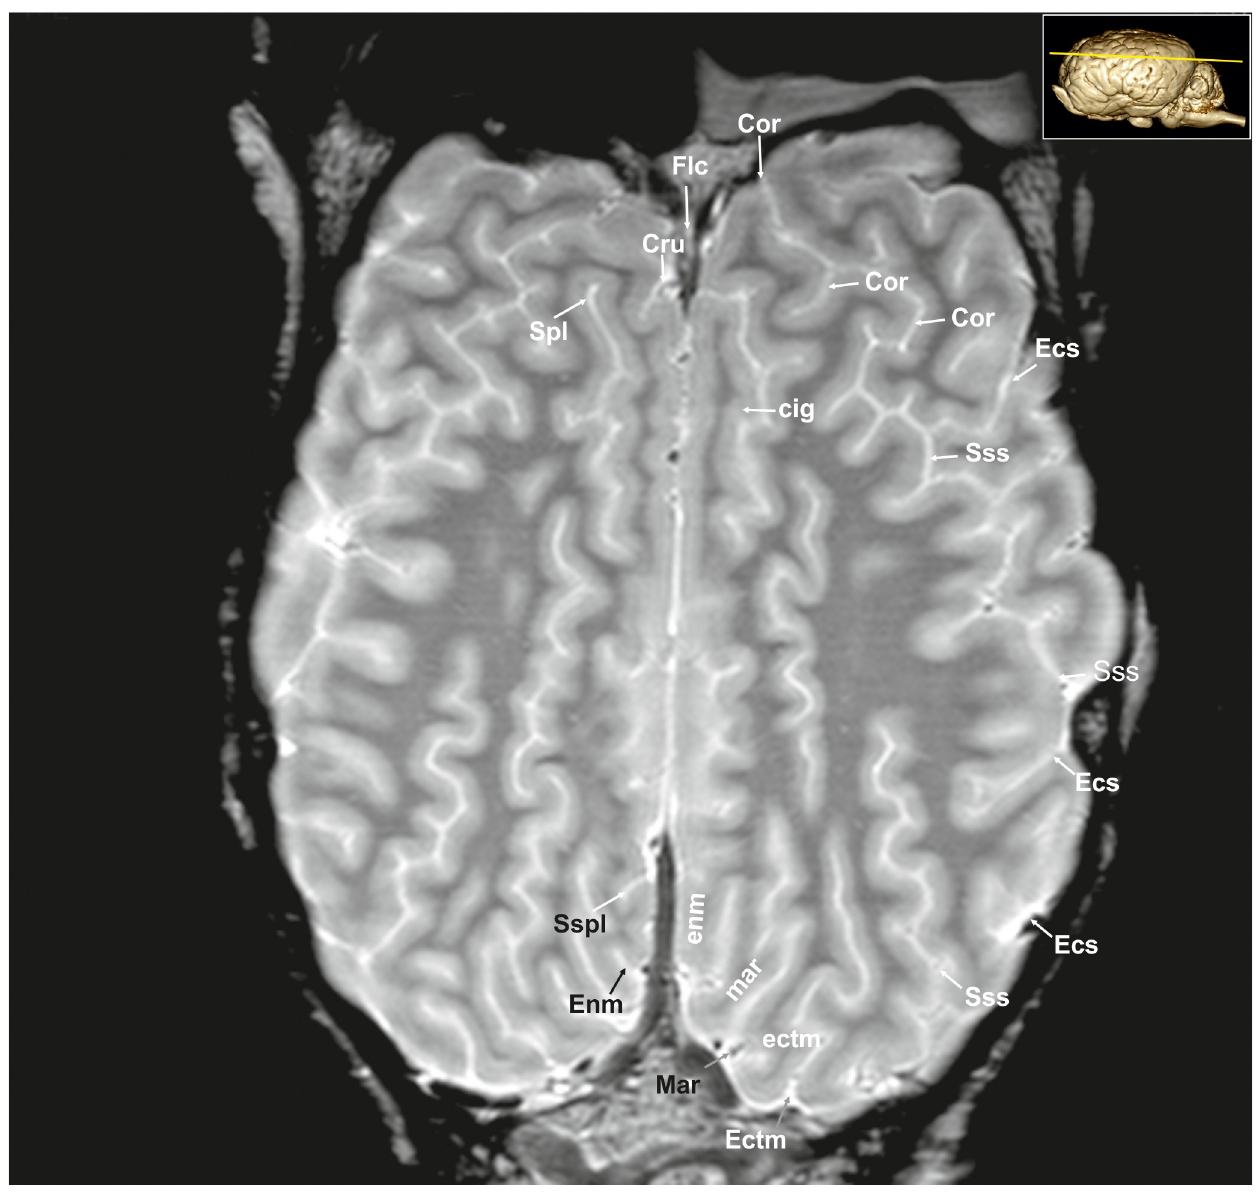
Fig 25. Dorsal magnetic resonance image of the equine brain on the level above the corpus callosum and cingulate gyrus. cig: cingulate gyrus, cin: cingulum, Cor: coronal sulcus, Cru: cruciate sulcus, Ecs: ectosylvian sulcus, Ectm: ectomarginal sulcus, ectm: ectomarginal gyrus, Enm: endomarginal sulcus, enm: endomarginal gyrus, Flc: longitudinal cerebral fissure, Mar: marginal sulcus, mar: marginal gyrus, Spl: splenial sulcus, Sspl: suprasplenial sulcus, Sss: suprasylvian sulcus.